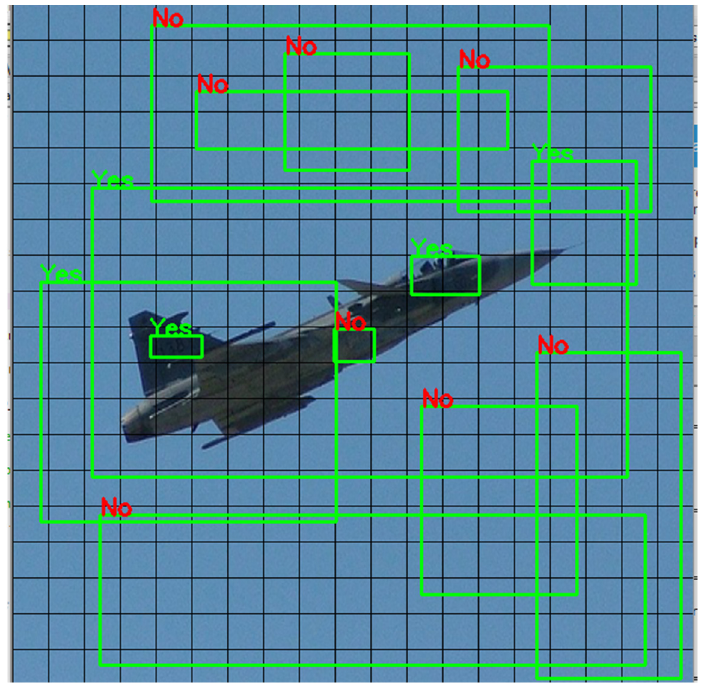
Figure 8. Efficient multi-scale anchor box (Example 1).